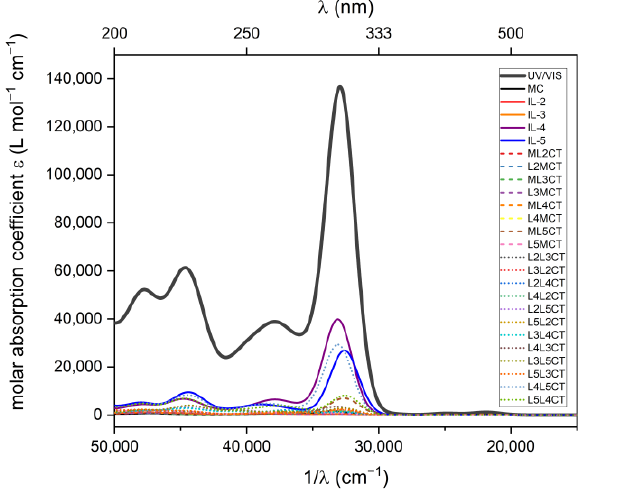
Figure 9. The DFT optimized molecular structure of 1′ in the low-spin state used for the calculation of 57 Fe Mössbauer parameters. The atoms are colored as following: iron (orange), nitrogen (blue), oxygen (red), and carbon (dark gray). Hydrogen atoms were omitted for clarity. Afterwards, TPSSh functional and ORCA 4.2.1 were used to calculate the quadrupole splitting (Δ E QTPSSh ) and the electron density at the iron nucleus ( ρ 0TPSSh ) — Table S8. The